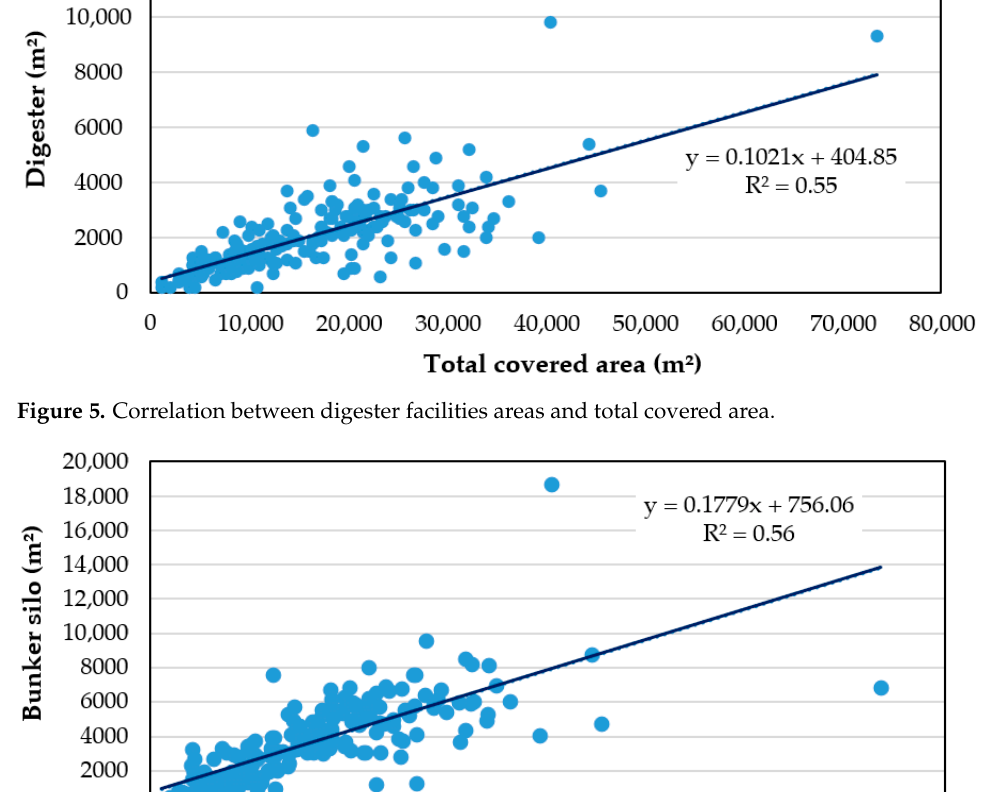
Figure 5. Correlation between digester facilities areas and total covered area.